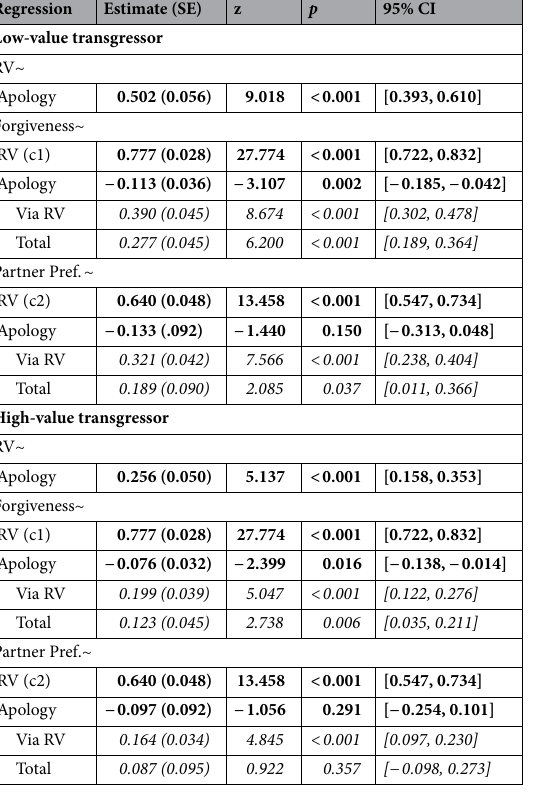
Table 3. Path coefficients for the simple effects of the apology manipulation across levels of the transgressor value manipulation. Coefficients are unstandardized, with coefficients pertaining to partner preference reported in log-odds. Confidence intervals were estimated using 1000 bootstrap samples. To distinguish direct effects from indirect and total effects, model direct effects are in bold while model indirect and total effects are italicized. Paths from perceived relationship value (RV) to self-report Forgiveness (c1) and Partner Preference (c2) were constrained to be equal across levels of transgressor value.